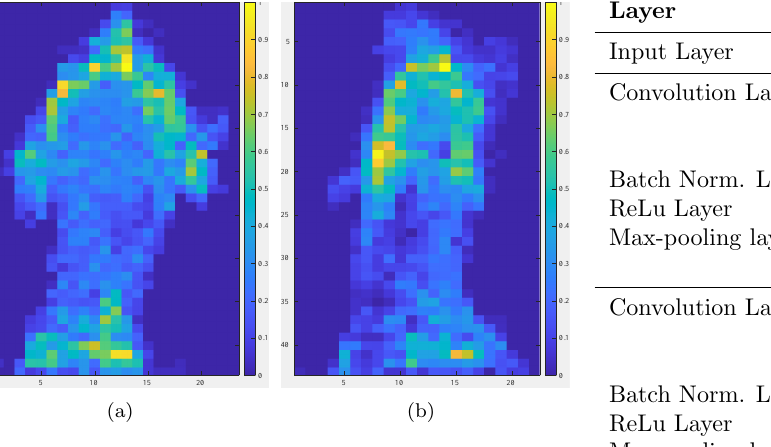
Figure 3: ( a ) Candidate cluster after flattening in the y dimension ( xz plane); ( b ) Candidate clus- ter after flattening in the x dimension ( yz plane). Color represents the accumulated in- tensity values, where yellow is higher.